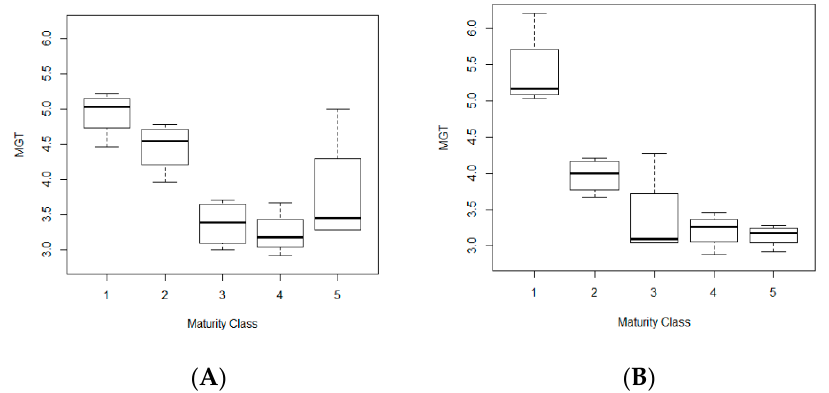
Figure 3. MGT as affected by seed maturity class in two water-to-seed ratios ( A ): 20 and ( B ): 40 mL/g seed) employed during washing.